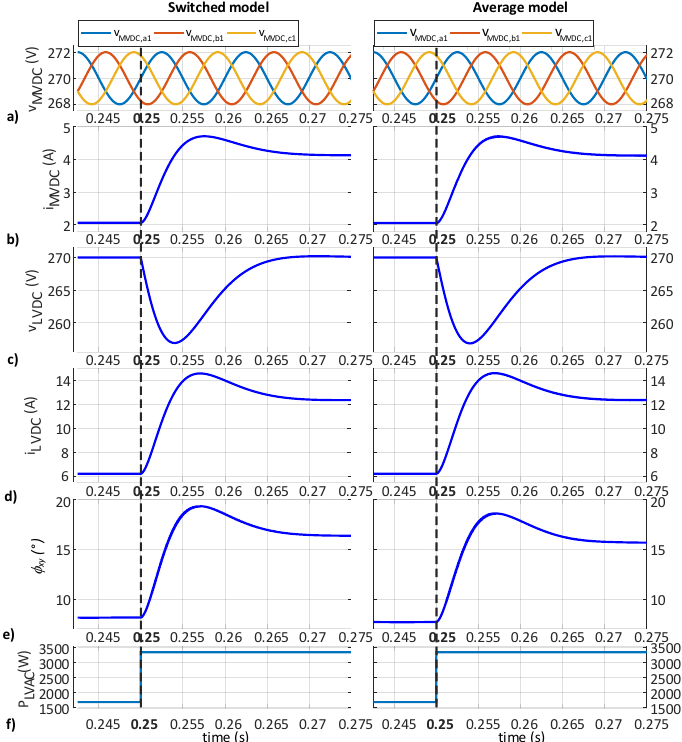
Figure 11. The voltages and currents of the three-phase DAB implemented in the ST, ( a ) DC-link voltages for one module in each phase (one transformer), ( b ) DC-link currents from MV side, ( c ) DC-link voltage from LV side, ( d ) DC-link current from LV side, ( e ) phase shift, ( f ) requested power value.